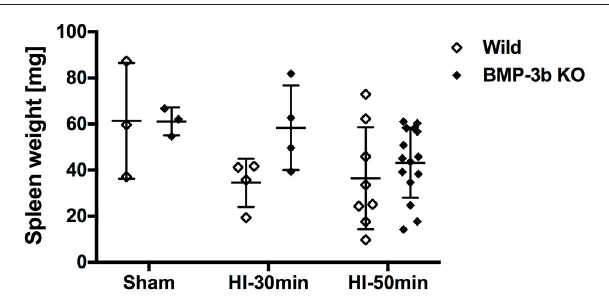
FIGURE 8 | Spleen weights at 14 days after surgery. Wild Sham, n = 3; Wild HI-30min, n = 4; Wild HI-50min, n = 8; BMP-3b KO Sham, n = 3; BMP-3b KO HI-30min, n = 4; and BMP-3b KO HI-50min, n =